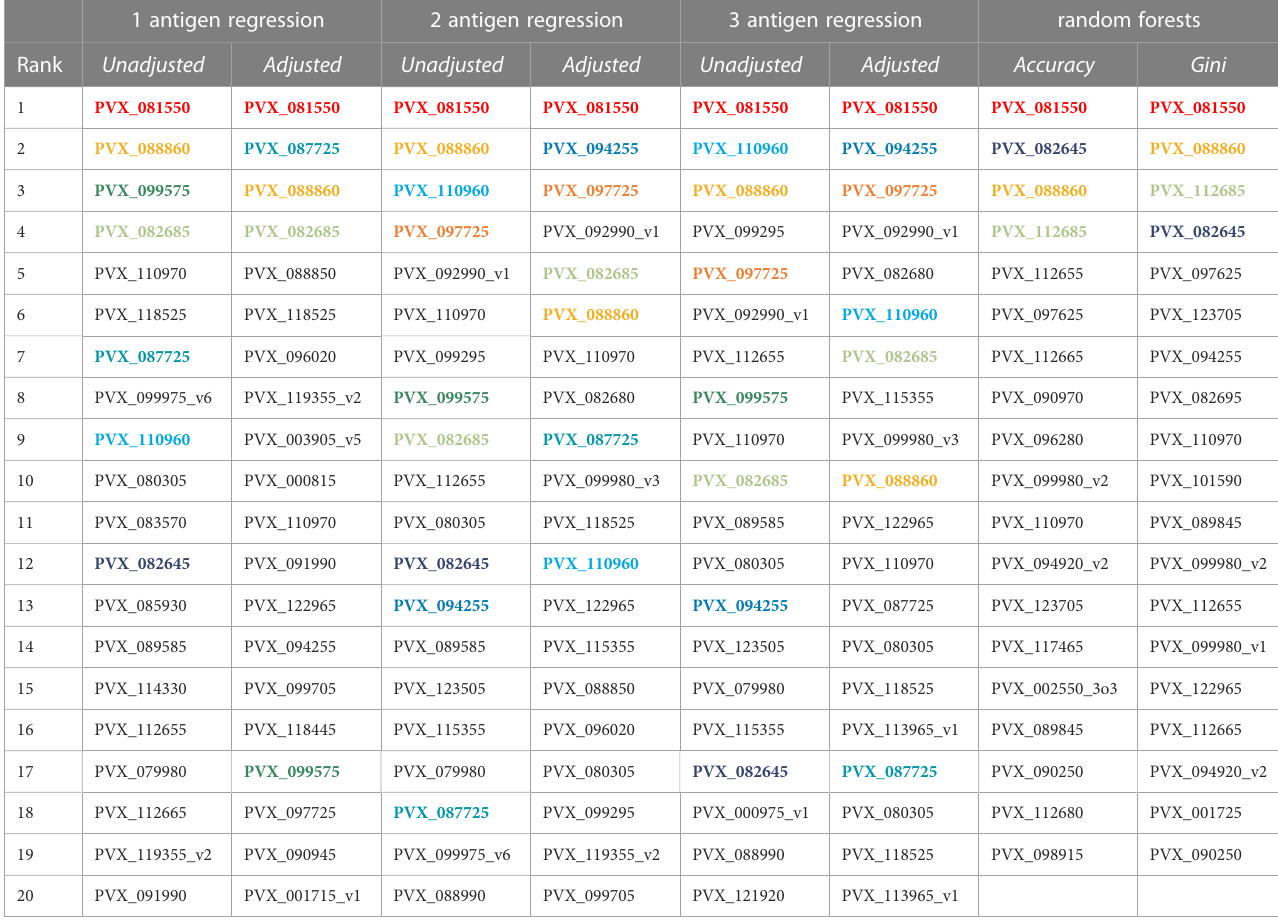
TABLE 1 Comparison of antigen ranking using single proteins versus combinations of two or